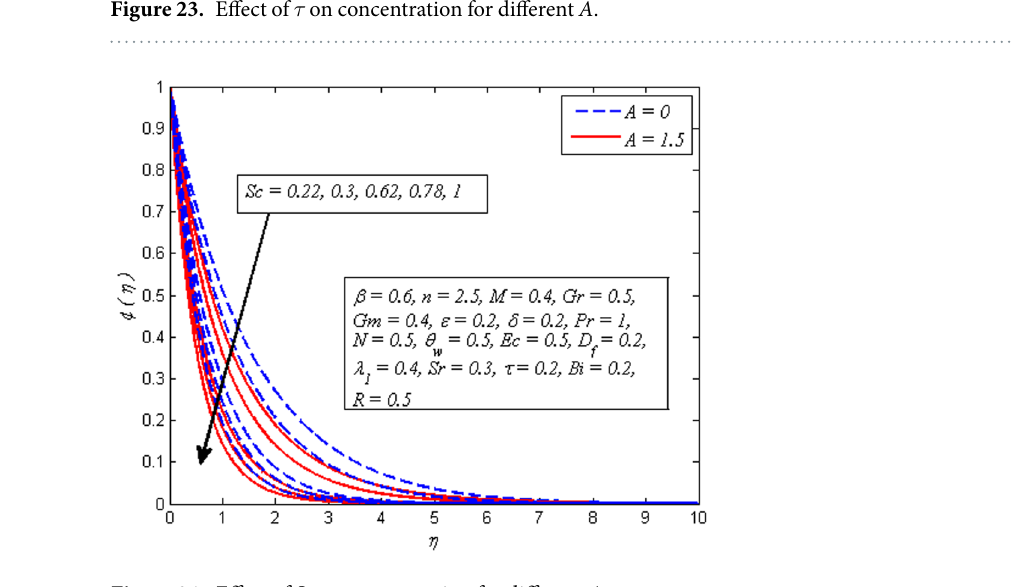
Figure 24. Effect of Sc on concentration for different A .